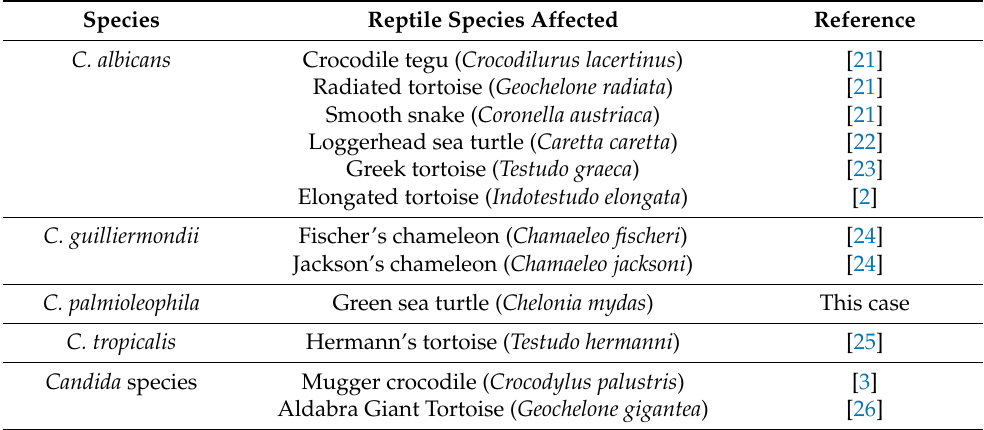
Table 2. Reported cases of Candida spp. infection in